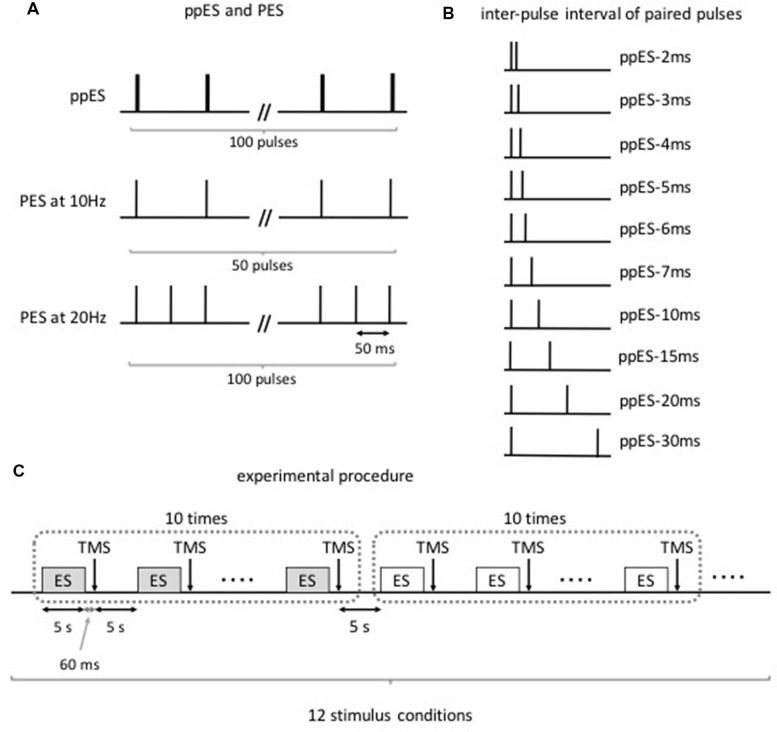
Paired-pulse electrical stimulation (ppES) and conventional peripheral electrical stimulation (PES) condition (Experiment 1).
(A) The ppES and conventional PES protocol. A ppES consisted of two single pulses delivered every 100 ms (total 100 pulses). In contrast, PES consisted of single pulse delivered every 100 ms (total 50 pulses) or 50 ms (total 100 pulses). (B) The inter-pulse interval of two single pulses in ppES. The inter-pulse interval between two single pulses was varied (2, 3, 4, 5, 6, 7, 10, 15, 20, 25, and 30 ms). (C) Each stimulus condition, including a 5-s stimulus period and 5-s rest period, was continuously performed 10 times. Single TMS pulse was delivered 60 ms after each stimulus period. The stimulus conditions were performed in the following order: ppES-2 ms, ppES-3 ms, ppES-4 ms, ppES-5 ms, ppES-6 ms, ppES-7 ms, ppES-10 ms. ppES-15 ms, ppES-20 ms, ppES-30 ms, PES at 10 Hz, and PES at 20 Hz. The condition order counterbalanced among the subjects using the Latin square.